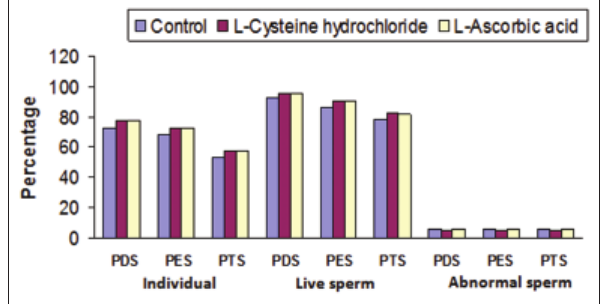
Figure-1: Individual motility percentage, live sperm percentage and abnormal sperm percentage at different stages of preservation with semen diluent